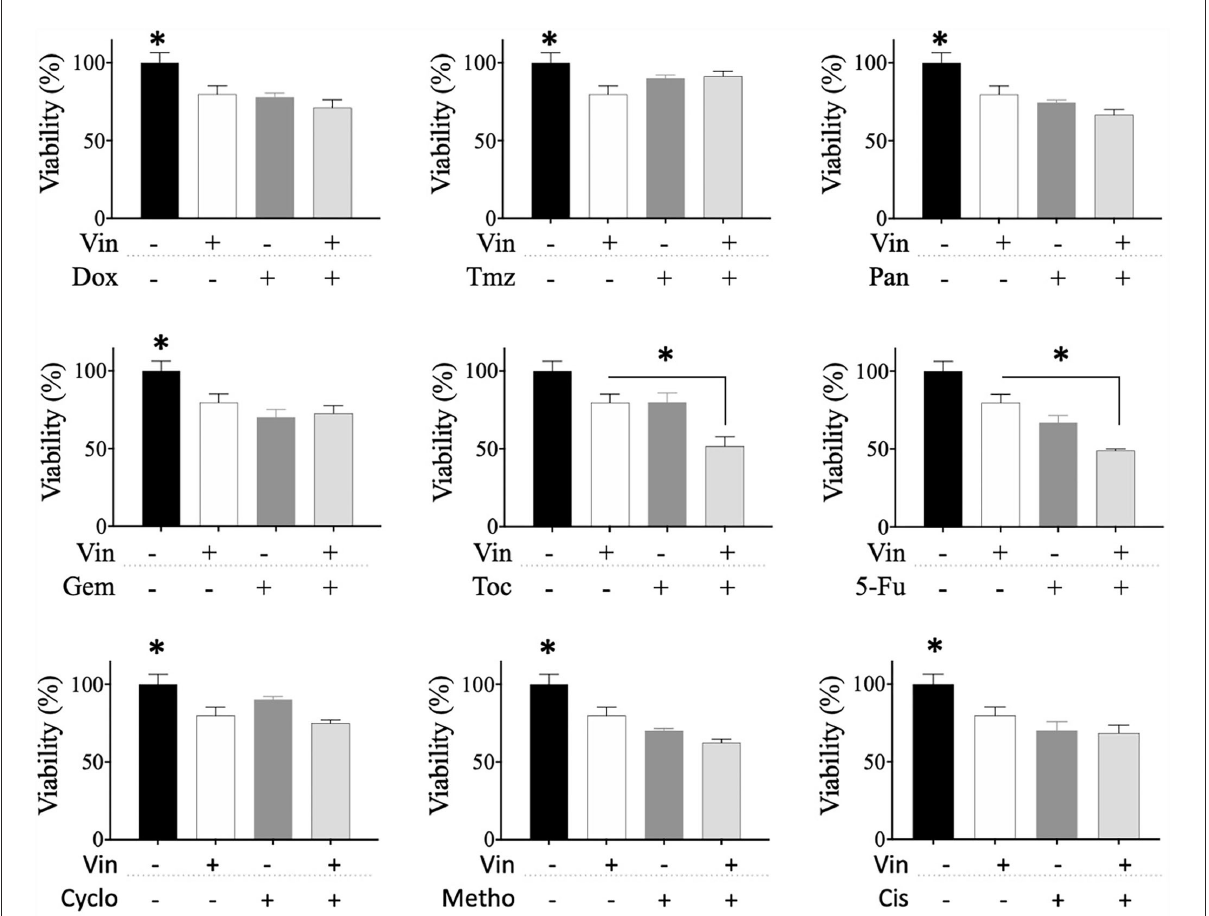
FIGURE4 Viability of CTVT cells exposed to the sequential administration of vincristine plus different drugs. CTVT cells (5 × 10 3 /well) were exposed to the CC 50 of Vin for 24h. Then Vin was withdrawn, and a 1:1 dilution of the CC 50 of Dox, Tmz, Pan, Gem, Toc, 5-Fu, Cyclo, Metho, or Cis was added for 24h. The relative cell viability was determined with the Alamar Blue assay. Each bar graph represents the average of 3 independent experiments ± SD. Statistical significance was determined using Tukey’s post hoc test (* p < 0.05). Vin, vincristine; Dox, doxorubicin; Tmz, temozolamide; Pan, panobinostat; Gem, gemcitabine; Toc, toceranib; 5-Fu, 5-fluorouracil; Cyclo, cyclophosphamide; Metho, methotrexate; Cis,